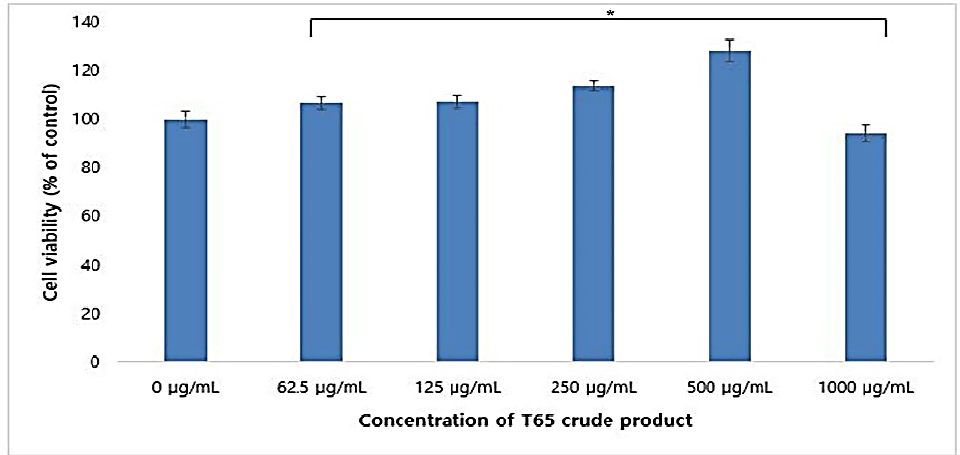
Figure 5. Proliferation of human dermal fibroblast (HDF) cells evaluated in CCD-986Sk cell line. Data are given as mean ± SEM. * p < 0.05 compared to control.